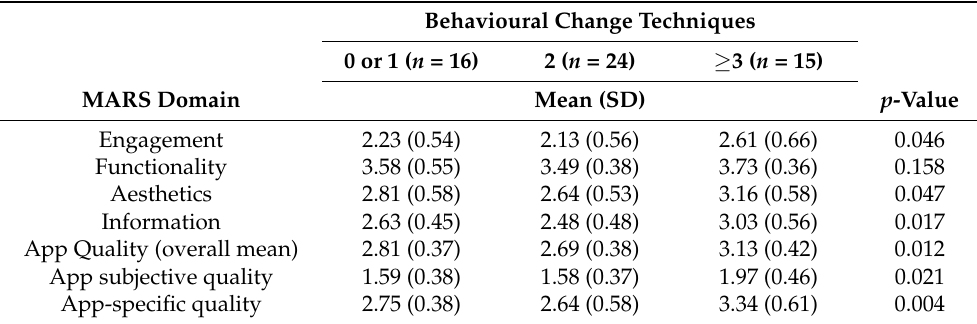
Table 4. App quality assessment scores according to presence of behaviour change